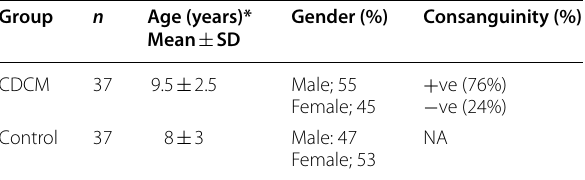
*No statistically significant difference was found between CDCM and control groups for ages, p